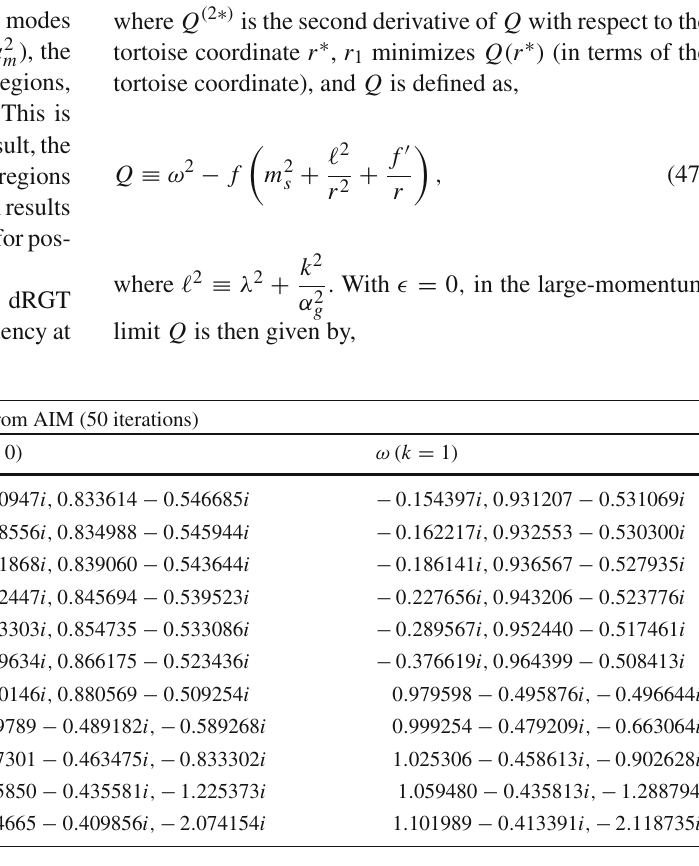
increases Re (ω) also increases but Im (ω) decreases. For low m s , the non-zero-real-part QNMs have larger | Im (ω) | than the purely imaginary mode, and they exist as higher modes.